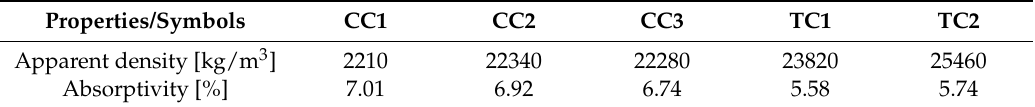
Table 8. The apparent density and absorptivity of tested composites